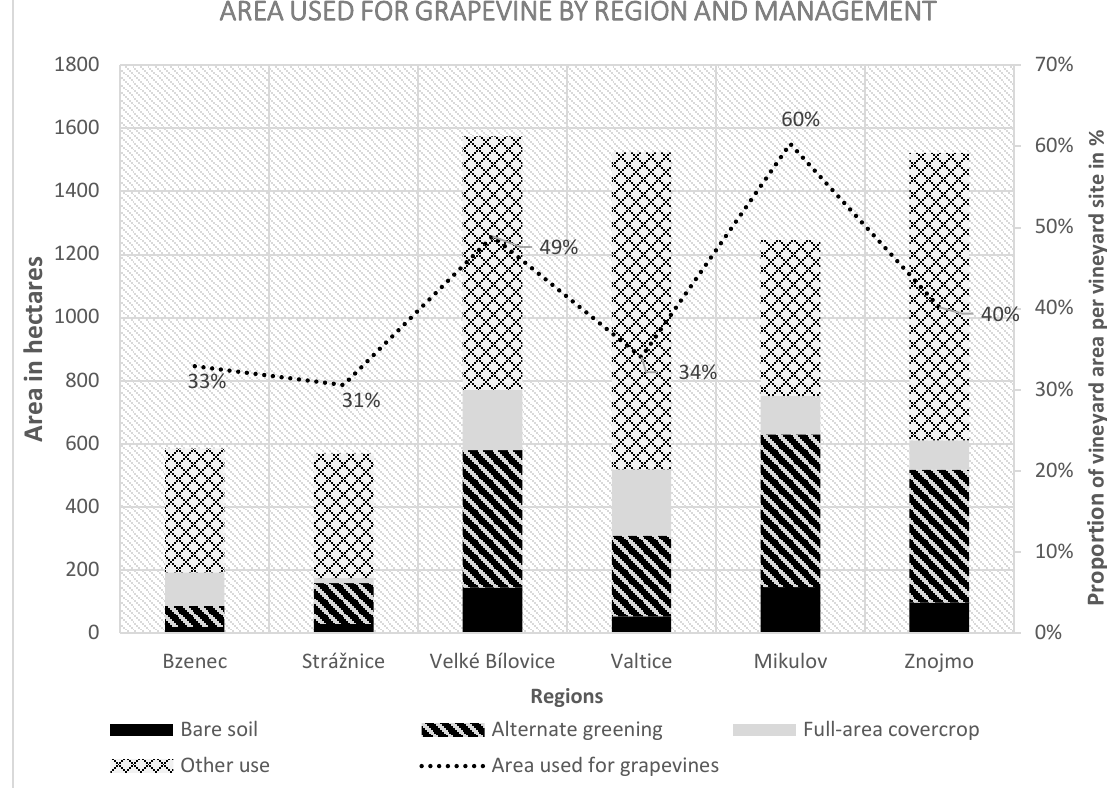
Figure 3. Area (in hectares) used for growing grapevines differentiated by greening management .